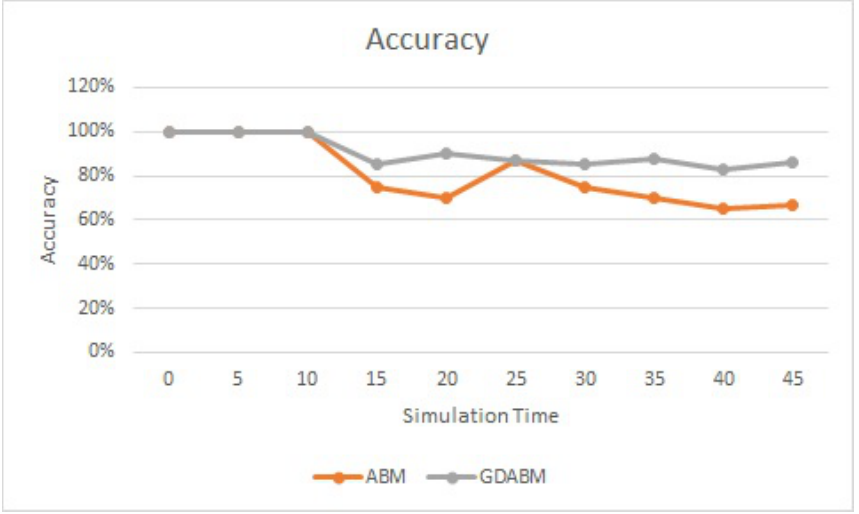
Figure 19. Comparison of the Accuracy for both ABM and